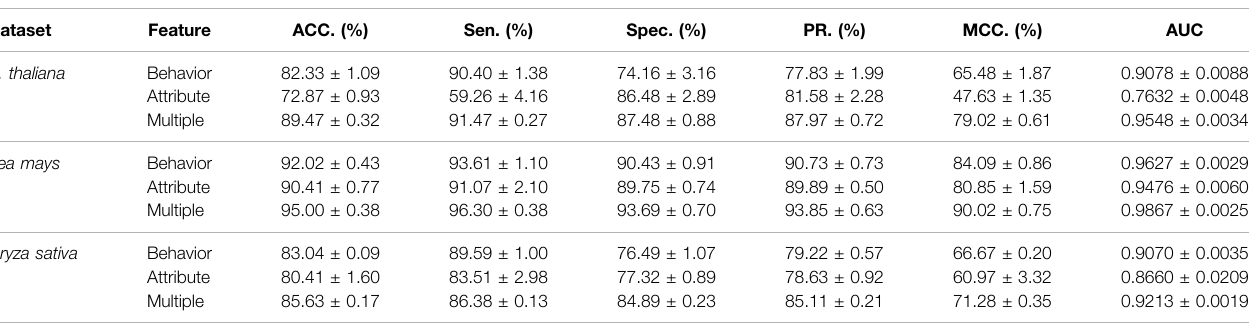
TABLE 5 | Prediction performance on the three plant PPI dataset with different information. Dataset